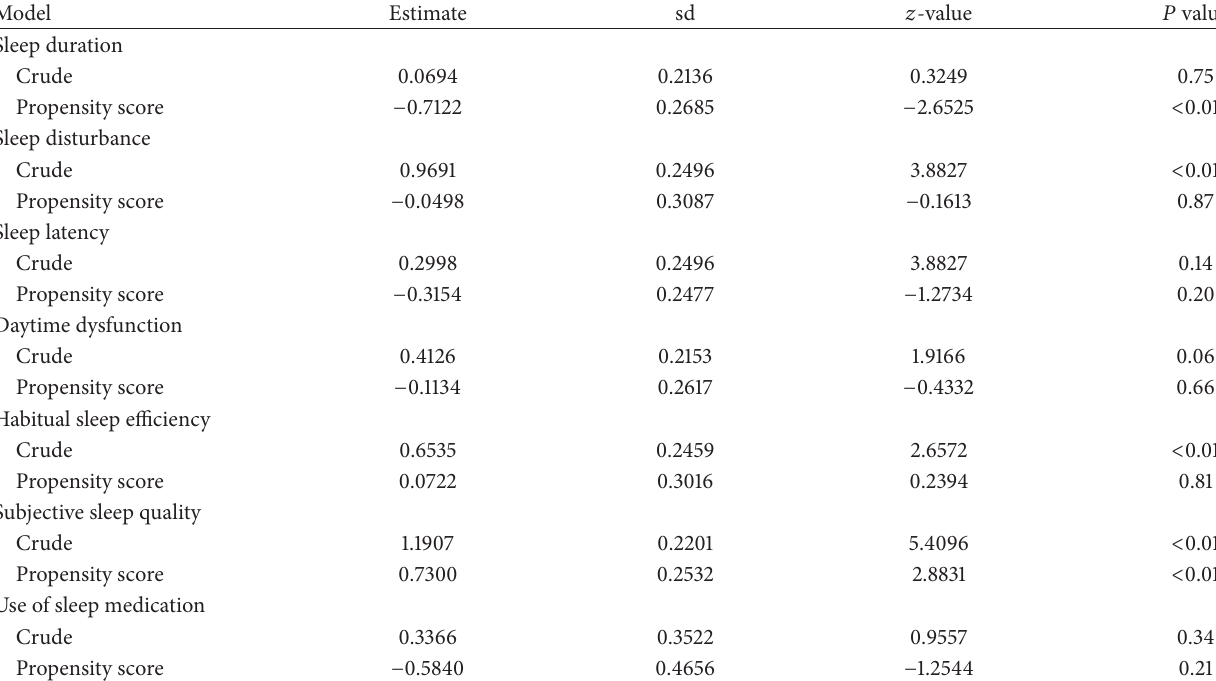
Table 5: Results of mTBI effect via cumulative logit model with or without propensity score as a covariate.